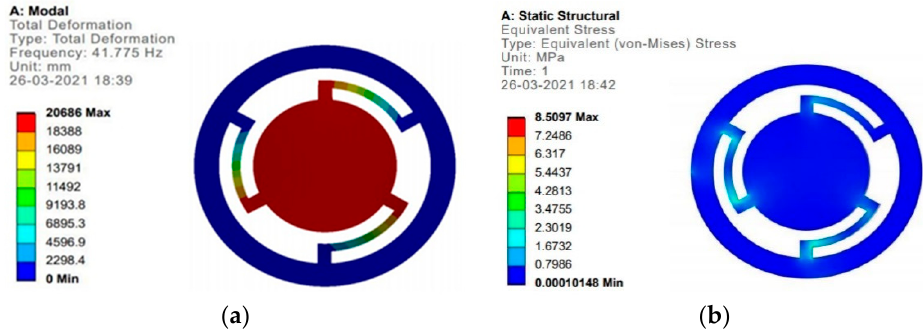
Figure 3. FEA of check-valves: ( a ) modal analysis; ( b ) static analysis. Table 1. Material selection (PET) of check-valves (https://designerdata.nl/materials/plastics/ thermo-plastics/polyethylene-terephthalate?cookie=YES (accessed on 26 March 2021)). Property